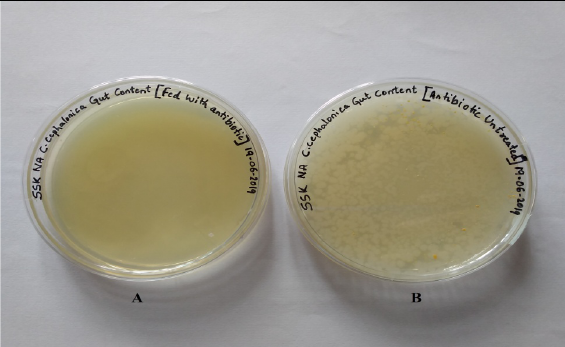
Figure 3. Nutrient agar plates: Antibiotic fed larval gut content (A) and Antibiotic unfed larval gut content (B) Larval gut microbial DNA There was no DNA in antibiotic fed larvae.